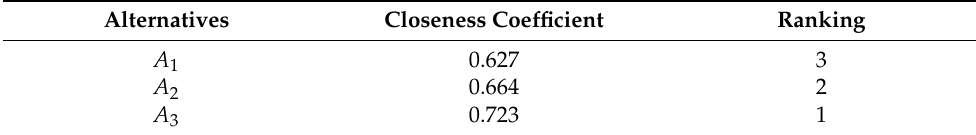
Table 5. The closeness coefficient values of Fintech projects and their